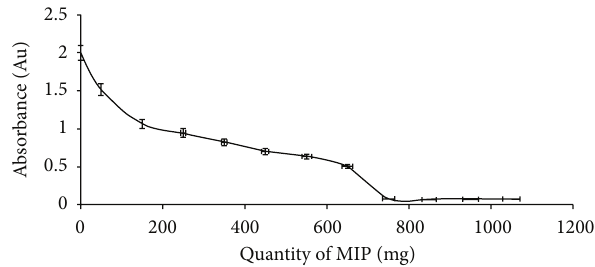
Figure 1: Optimization of the quantity of MIP needed to remove maximum chlorophyll in 24h at pH 7. 𝑛 = 3 .